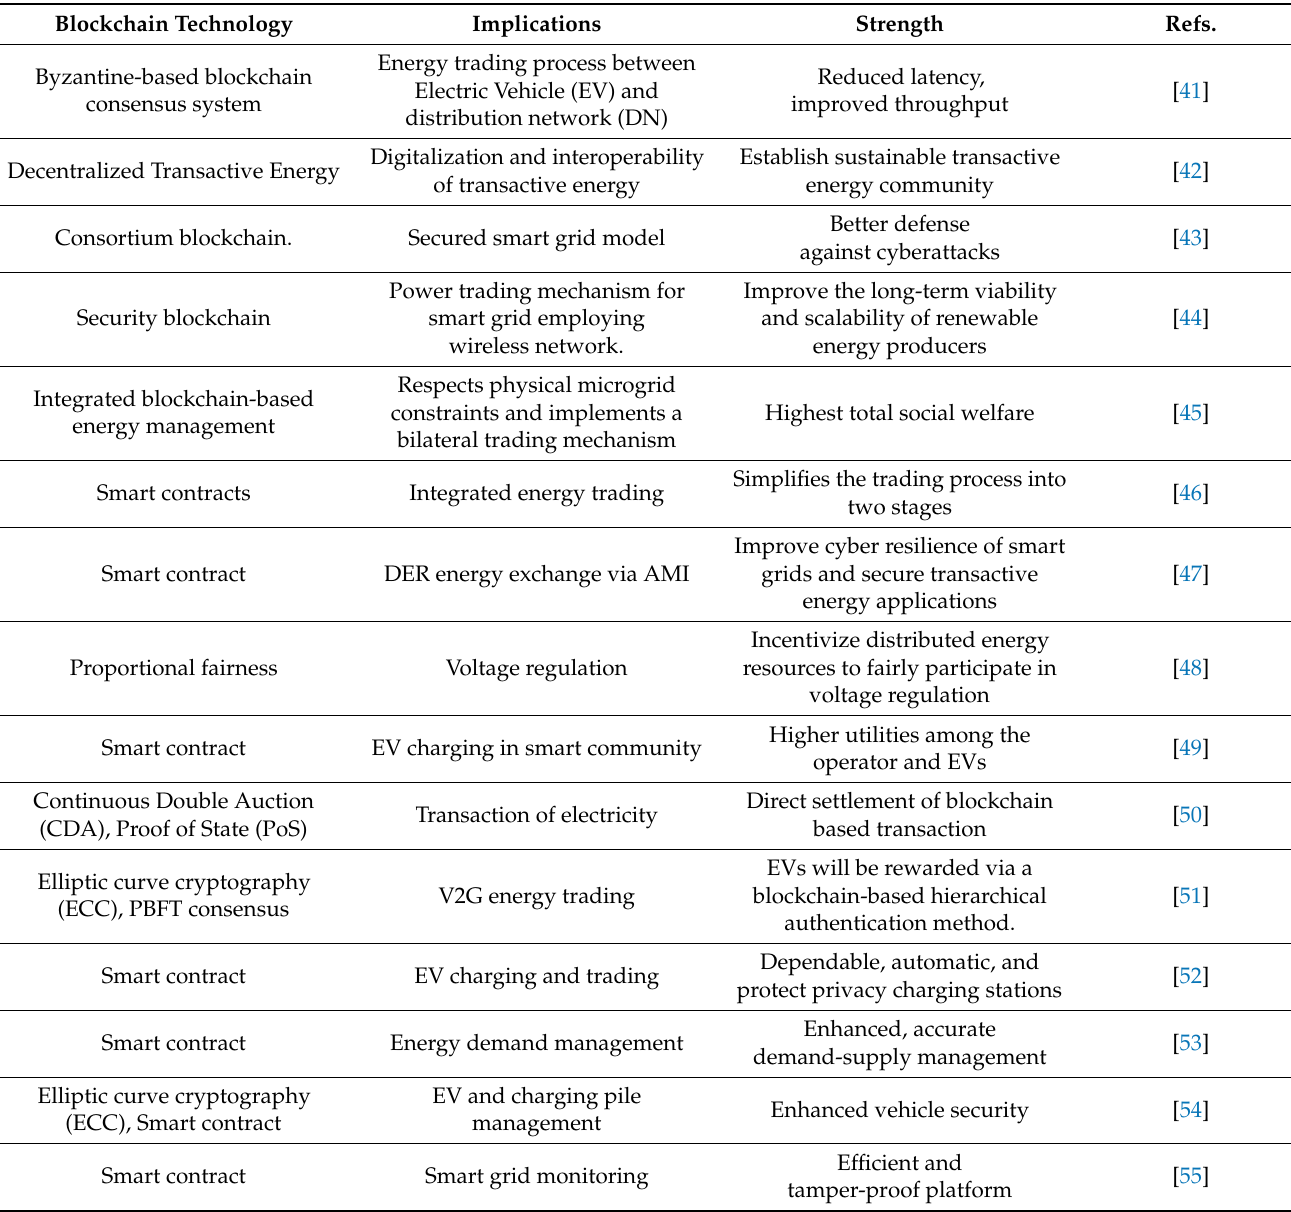
Table 1. Blockchain implications for transactive